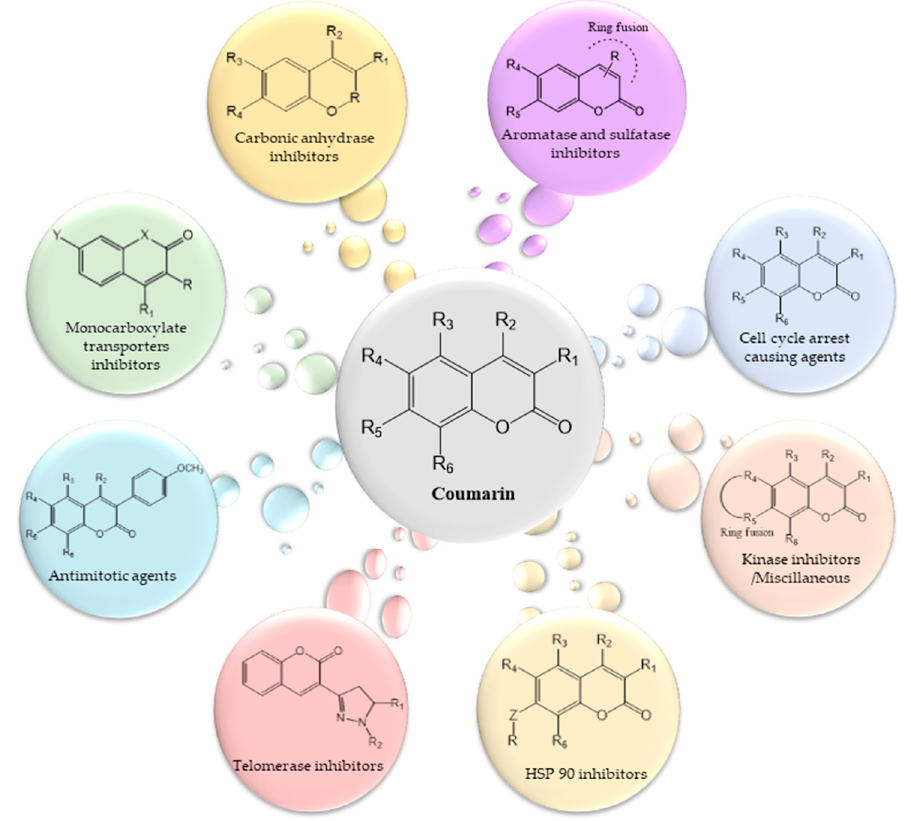
Figure 7. Roles of coumarins in anticancer activity with structure activity relationship.